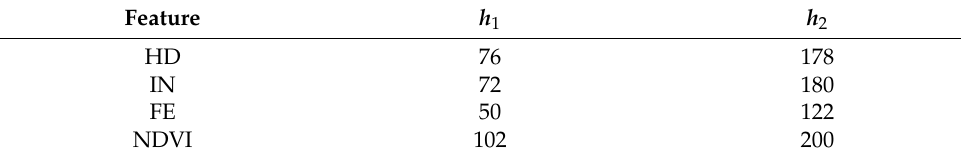
Table 1. Thresholds of feature images.